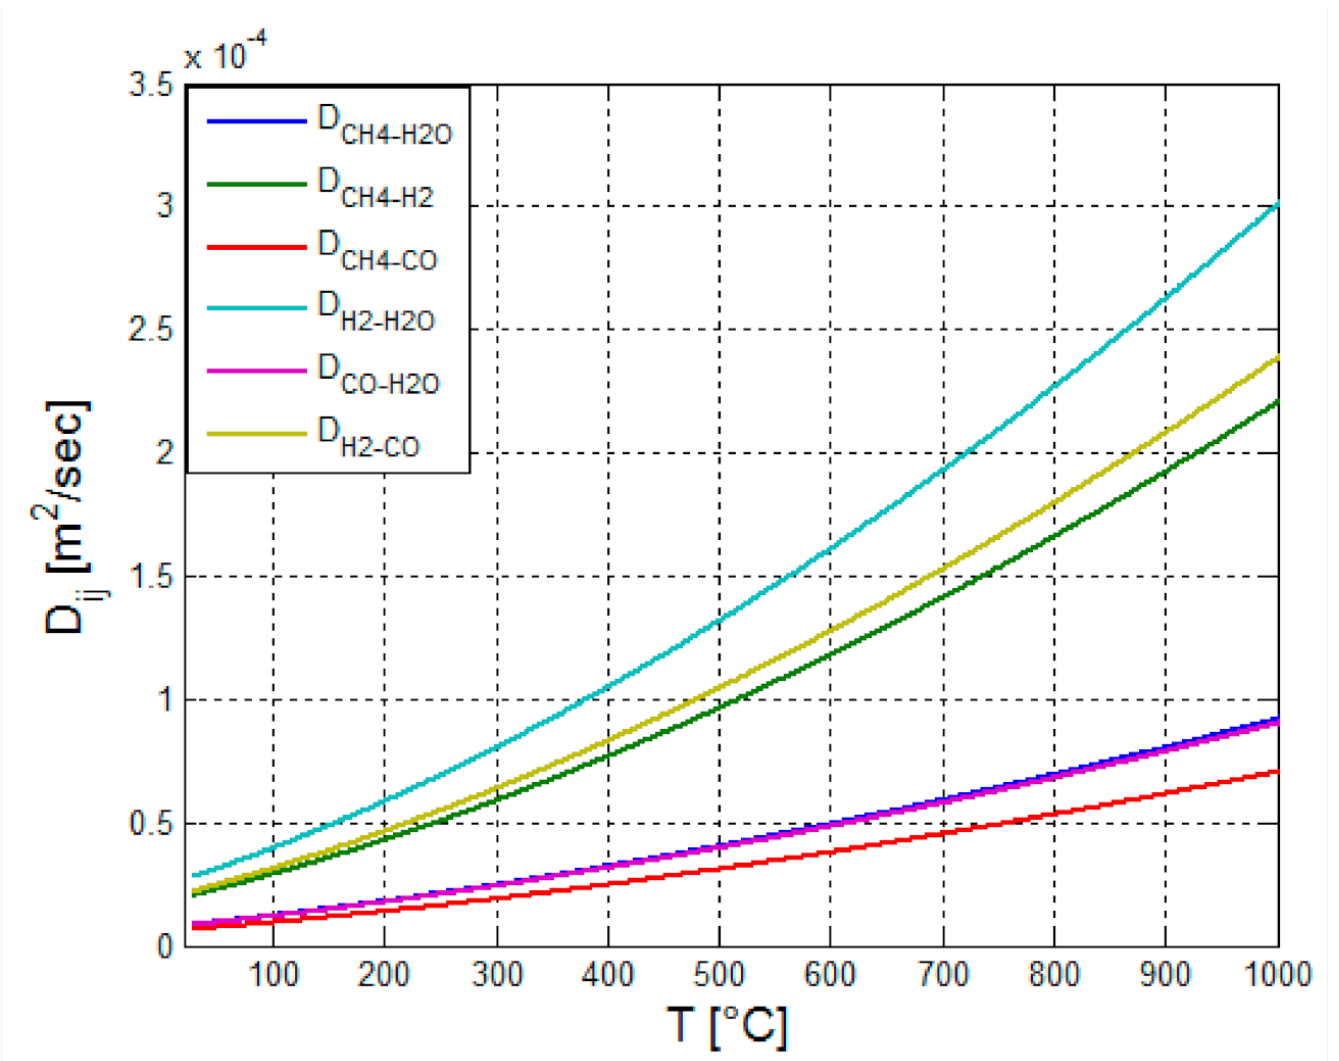
Figure 10. The diffusion coefficients of the gaseous components as a function of the